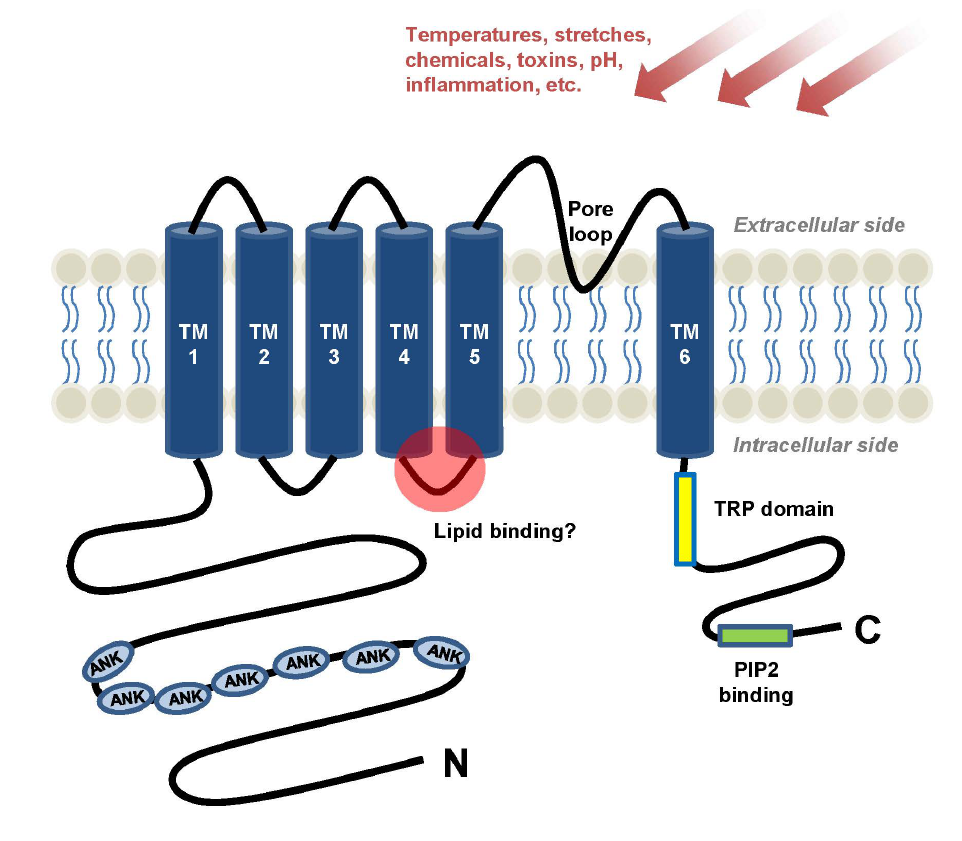
Figure 1. A topological structure of sensory TRP channels is illustrated. A subunit of the sensory TRP channels has six membrane-spanning (transmembrane) domains. Between TM5 and TM6 domains, the pore loop that allows ionic flow is located. Amino and carboxyl termini are located in the cytosol. Some of sensory TRPs contain multiple ankyrin repeats at their amino termini. One of important locations to interact with endogenous lipid regulators or lipophilic pharmacological agents ( i.e. , capsaicin) is predicted to be